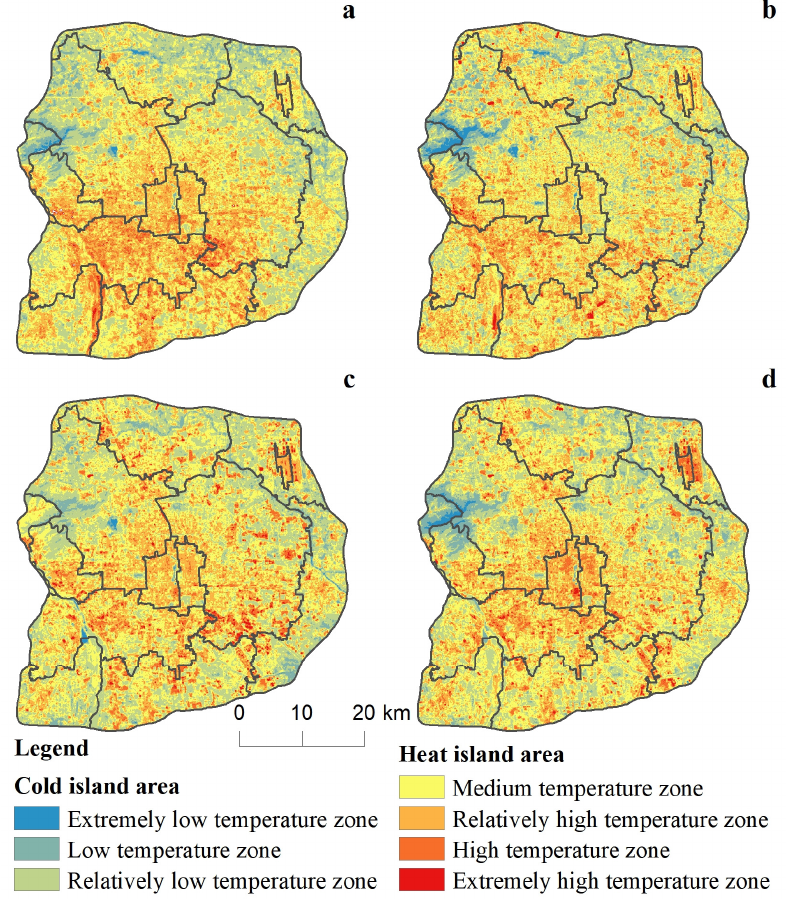
Figure 4. Distribution of the thermal grade within the sixth ring road of Beijing in: ( a ) 2004, ( b ) 2009, ( c ) 2014, ( d ) 2019.